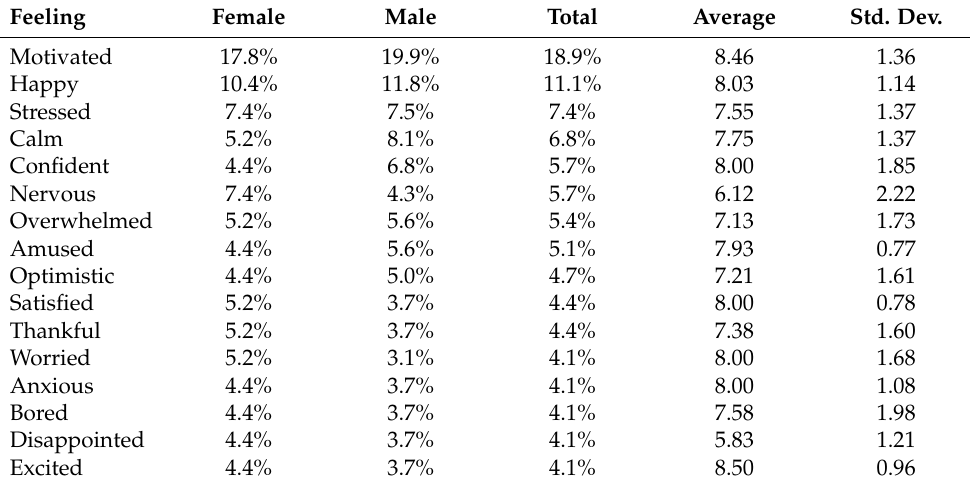
Table 2. Primary feeling and intensity